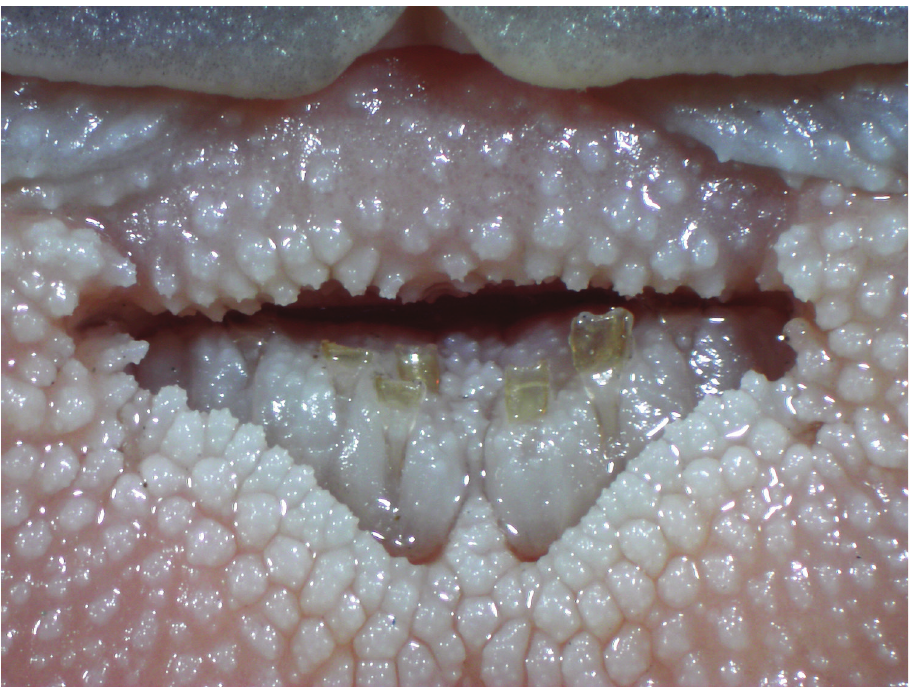
Figure 2. Tooth band of Oreoglanis hponkanensis , SEABRI CXY20150106, paratype, male, 120.64 mm SL.